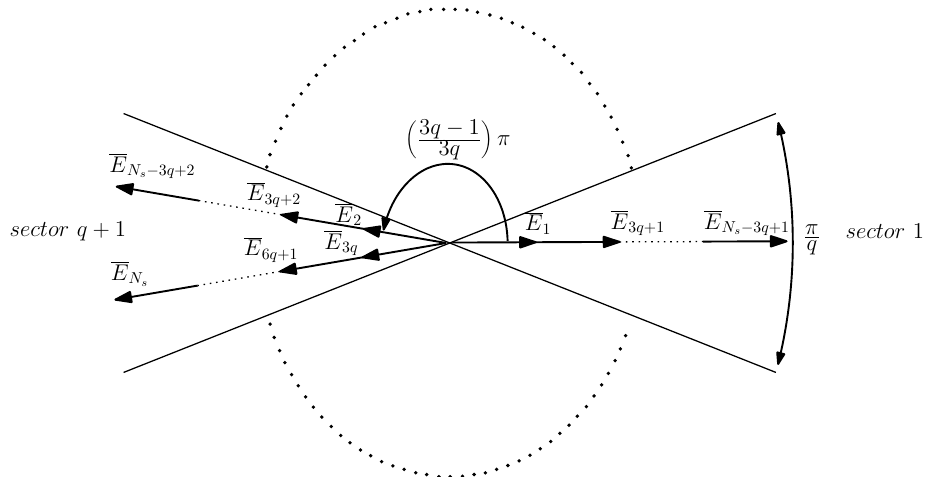
Figure 5. Star of slots of the FSPMSMs with an odd number of phases arranged in double-layer slots under investigation.